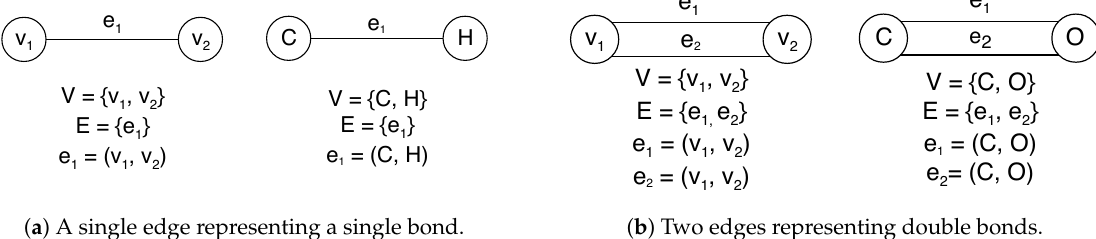
Figure 5. The general concepts of undirected graphs and their abstraction for representing molecules as undirected graphs using labels as atoms and number of edges as